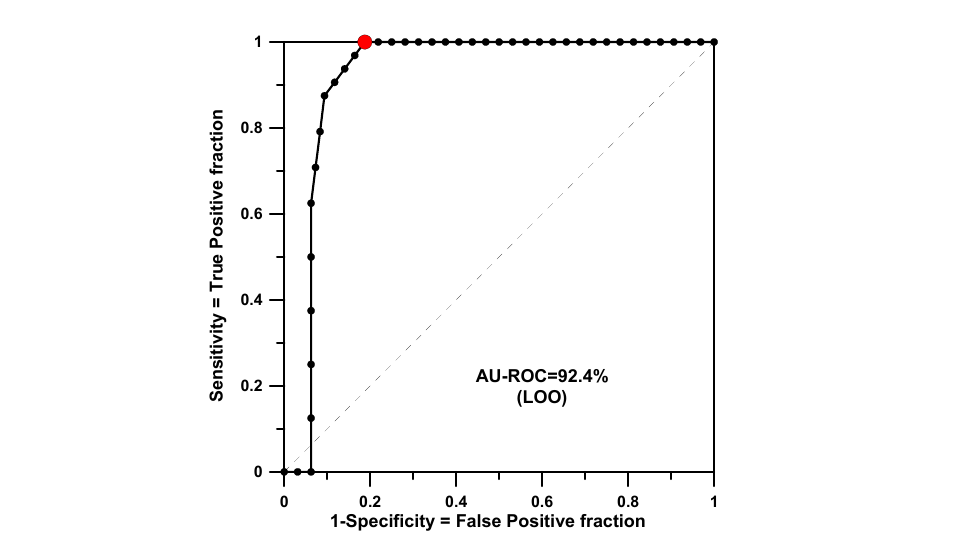
Figure 3. AU-ROC plot for CGM obtained with a LOO cross-validation calculation.